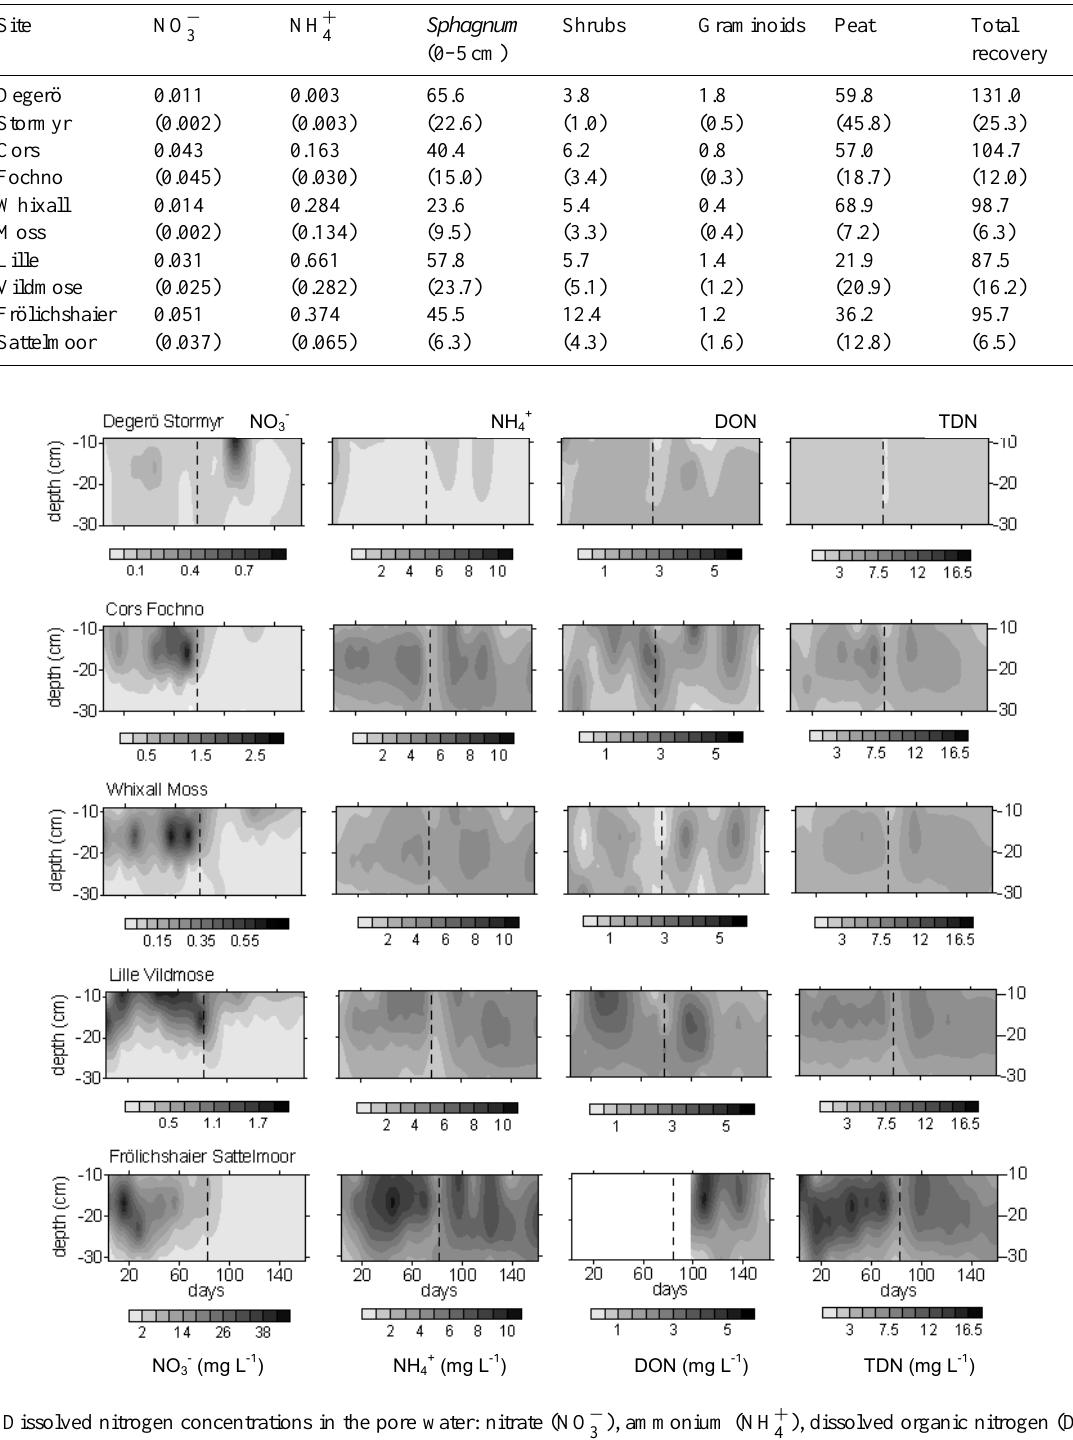
), ammonium (NH + ), dissolved organic nitrogen (DON), and 3 4 . Vertical dashed lines mark the transition between dry (left) and 3